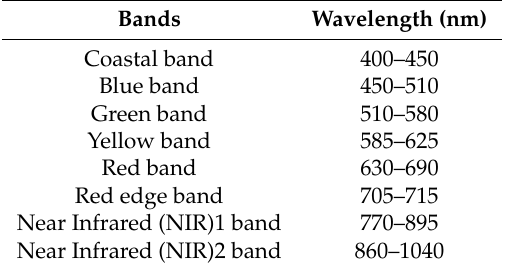
Figure 2. The WV3 image data: the original image and the study area in Sassuolo. Table 1. Eight multispectral bands along with their wavelengths in the WV3